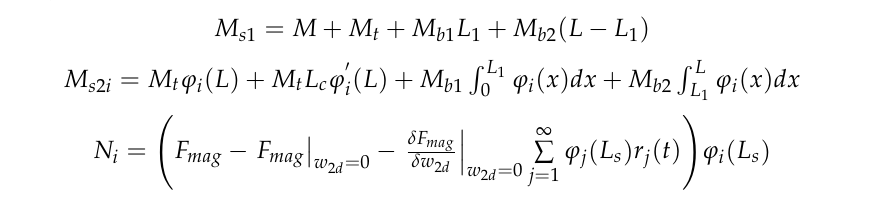
Table 2. Reduced-order model’s parametric